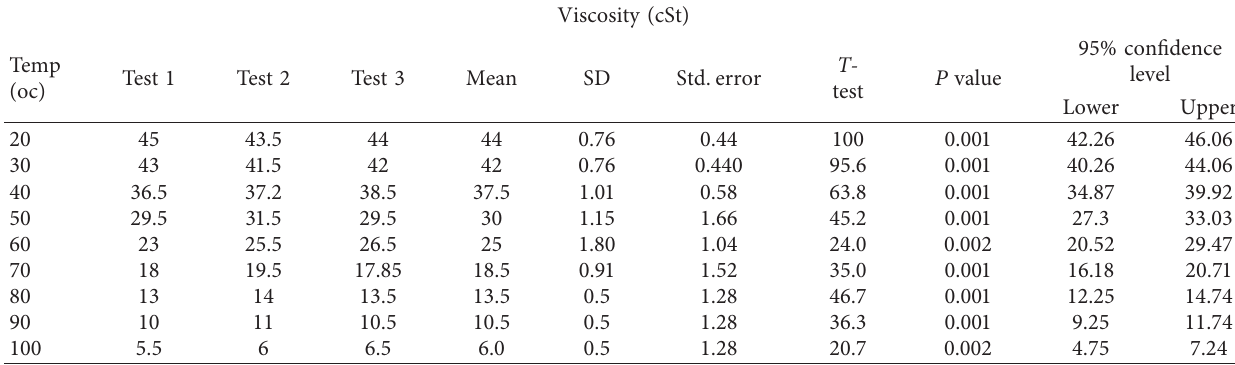
Figure 2: Hood-type experimental setup for stove testing. Table 1: The change in viscosity of Jatropha oil with temperature increment.